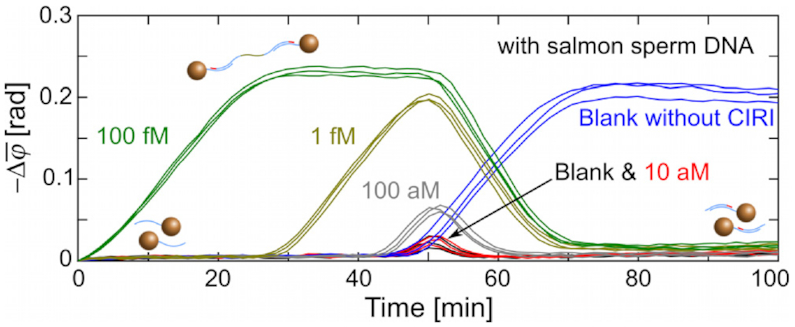
Real-time changes of \documentclass[12pt]{minimal}
\usepackage{amsmath}
\usepackage{wasysym}
\usepackage{amsfonts}
\usepackage{amssymb}
\usepackage{amsbsy}
\usepackage{upgreek}
\usepackage{mathrsfs}
\setlength{\oddsidemargin}{-69pt}
\begin{document}
}{}$\bar{\varphi }$\end{document} (1–10 Hz) for the measurement of CIRI-controlled PG-RCA in samples containing 0.1 μg/ml sheared salmon sperm DNA. Independent replicates (n= 3) are plotted in the same color. Blue curves are from Figure 3A for reference.